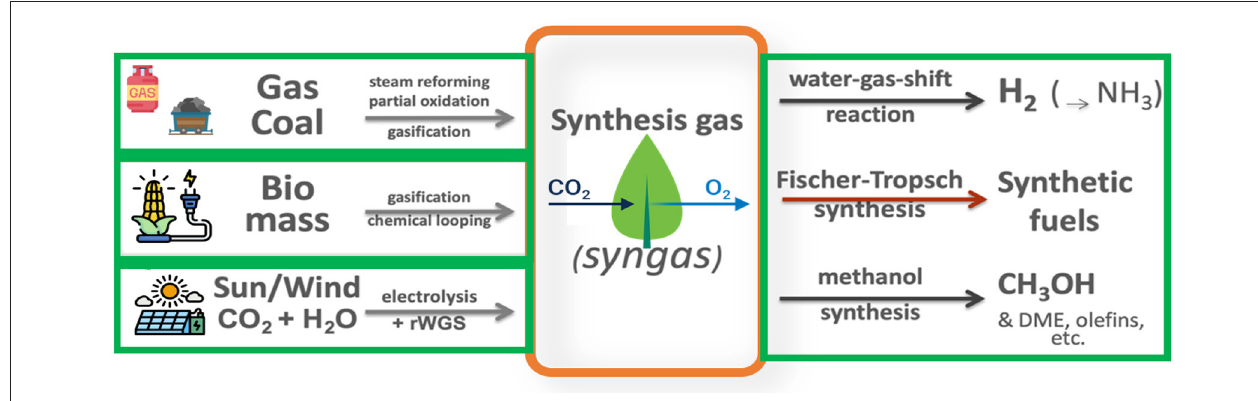
FIGURE 6 | Chemical reaction of synthetic fuel production (Christiansen and Rostrup-Nielsen,